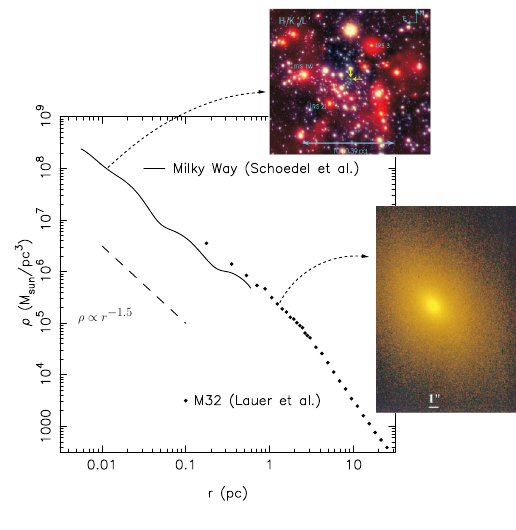
Fig. 7 Density profile for the GC of the MW and for M32, both with MBHs of masses 3 × 10 6 M (cid:2) and influence radii ∼ 3 pc. The dashed curve on the very left corresponds to a slope of ρ ∝ r − 3 / 2 . Image adapted from Merritt (2006), Schödel et al. (2002), Lauer et al. (1998)